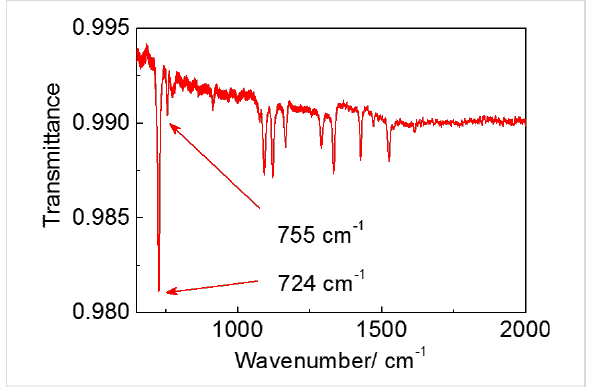
Figure 3: IR transmission spectrum of a 10 nm thick CoPc film deposited on a Si substrate normalized to the IR spectrum of a Si sub-